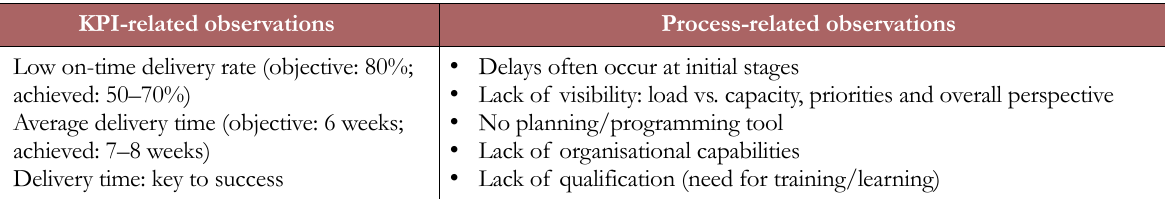
Table 4. Synthesis of the initial situation